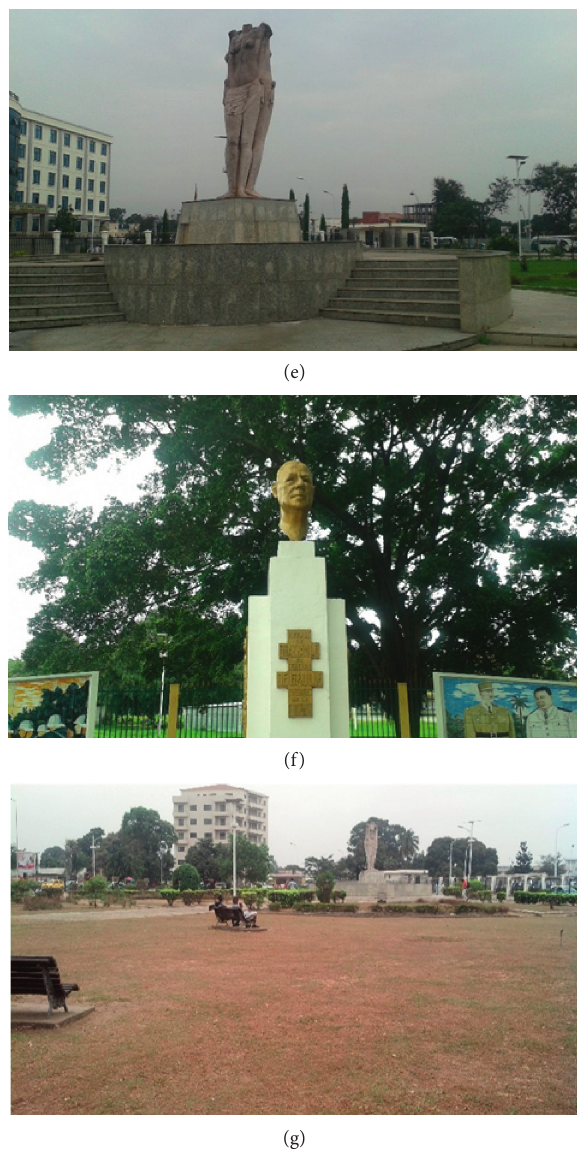
Figure 8: Prefecture hotel garden (a, d, and g); Sainte-Anne garden (b); Marien Ngouabi museum garden (c); and Lyc´ee Pierre Savorgnon de Brazza garden